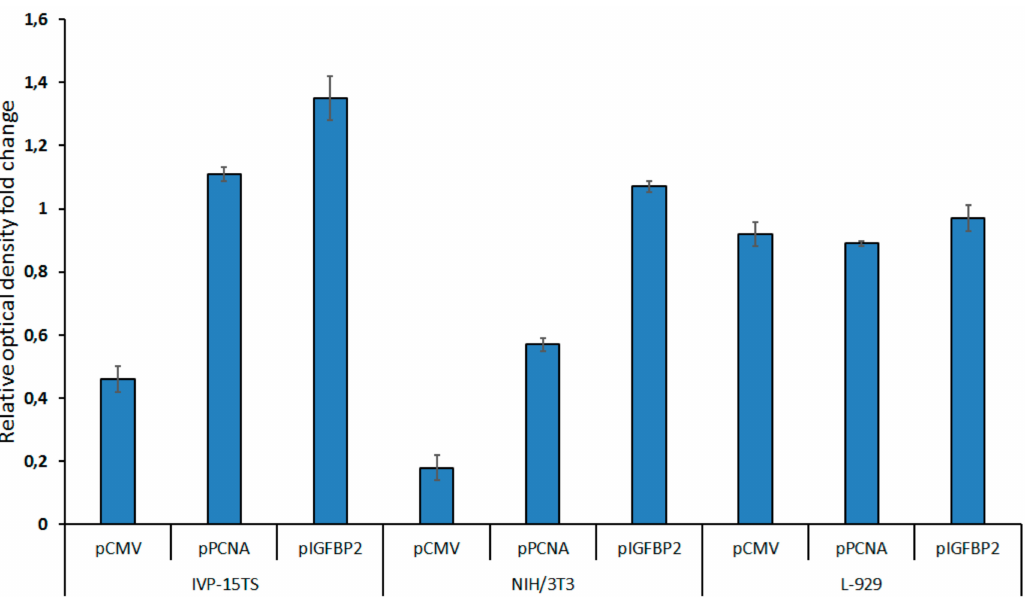
Figure 4. Cell proliferation after 2 weeks of transduction as measured by MTS test. The diagram presents the values of relative optical density of the cells carrying the HSVtk - GFP transgene under the control of pCMV, pPCNA, or pIGFBP2 promoters. The growth rate of non-transduced control cells was taken as one. The measurements were carried out in three technical replicates for each sample and are represented as mean ± s.e.m.